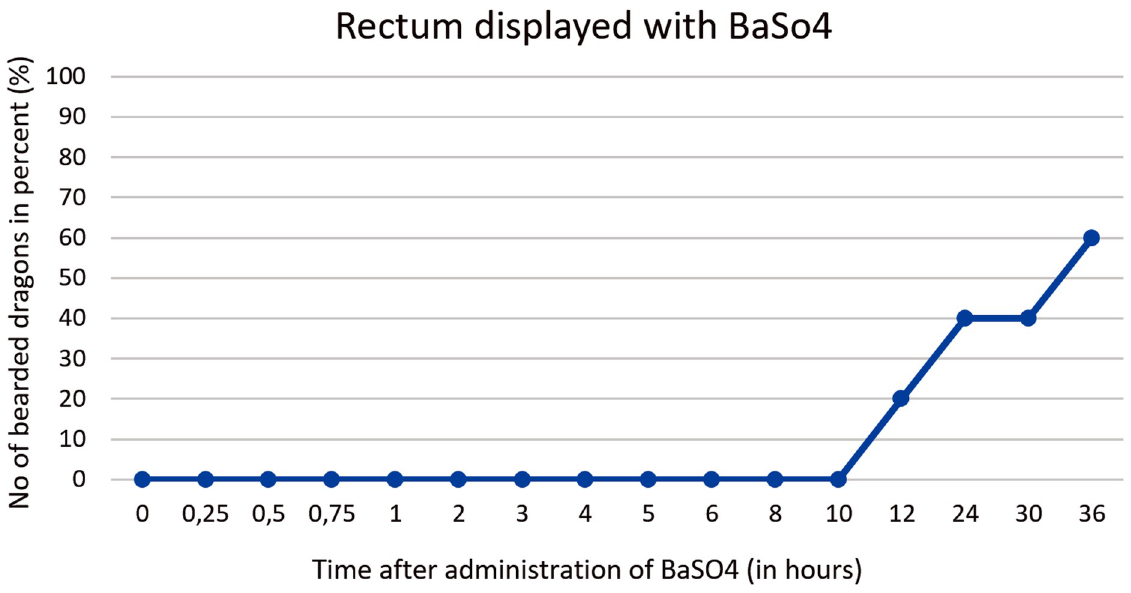
Fig 17. BaSO 4 contrast visibility in the rectum over time. Percentage of animals and frequency at measuring time point; y = number of animals in percent (%) in which contrast media could be found in the rectum; x = time point during BaSO 4 contrast passage (hours).